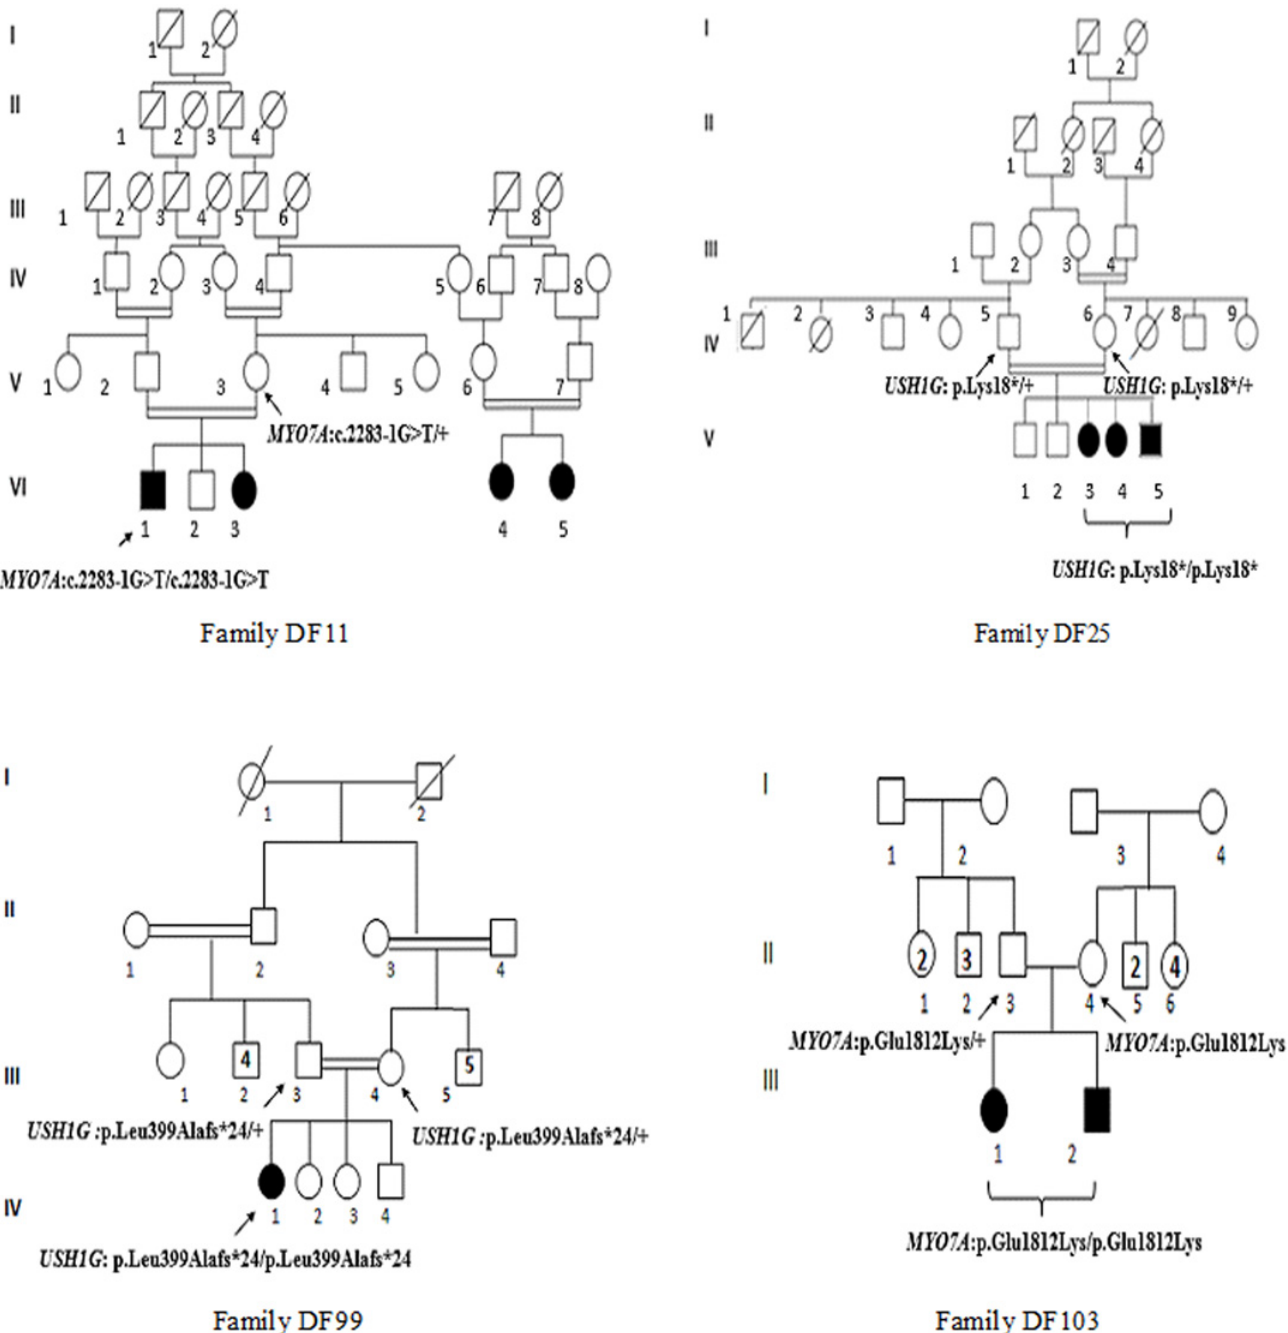
Fig 1. Pedigrees of the four Tunisian patients analyzed by whole exome sequencing. Squares and circles denote males and females, respectively. Filled symbols indicate deaf individuals. Arrows indicate the individuals analyzed by WES.